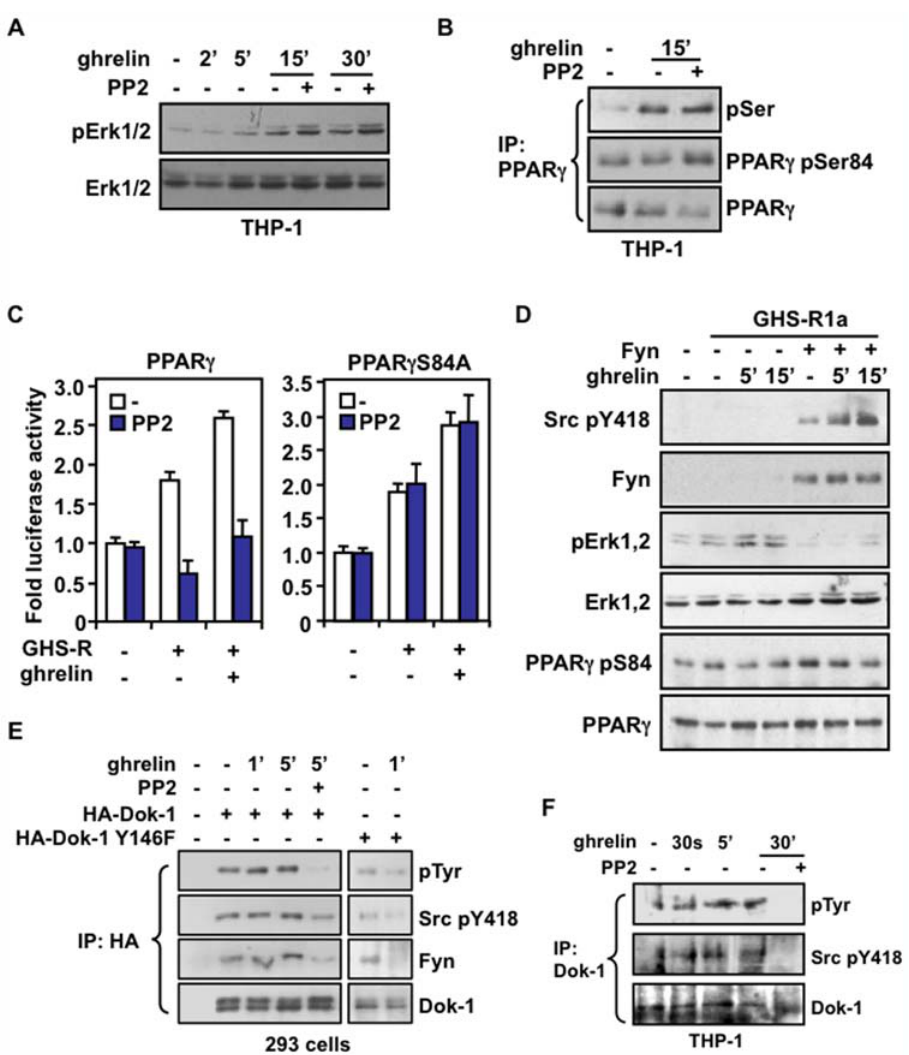
Figure 5. The ghrelin-induced PPAR c activation involves a negative regulation of Erk through Fyn/Dok-1 interaction. ( A ) Src inhibition increases Erk1/2 activity in differentiated THP-1 cells serum-deprived for 16 h and incubated with 1 m M PP2 for 30 min before incubation with 10 nM ghrelin for 2 to 30 min. The lysates were analyzed by immunoblot with antibodies specific to phospho-Erk1/2 and total Erk1/2. ( B ) Phosphorylation of PPAR c Ser-84 is increased by Src inhibition in THP-1 cells. Cells were treated as in (A), and lysates were immunoprecipitated with an antibody against PPAR c and analyzed by immunoblot using antibodies against phospho-serine, PPAR c pSer-84, and total PPAR c . ( C ) The PPAR c S84A mutant is insensitive to Src inhibition. 293 cells were transfected with UAStkLuc reporter in absence or presence of GHS-R1a, and with Gal4- PPAR c ( left ) or Gal4-PPAR c S84A ( right ) plasmids. Cells were then treated with 10 nM ghrelin with or without 1 m M PP2 for 20 h, and harvested for luciferase assay. Normalized values are presented as fold changes 6 SEM compared with untreated cells in presence of GHS-R1a. ( D ) Expression of Fyn inhibits Erk1/2 activity and PPAR c Ser-84 phosphorylation in the presence of ghrelin. 293 cells were transfected with GHS-R1a, Fyn and PPAR c expression plasmids, and then treated with 10 nM ghrelin for 5 and 15 min. Cell lysates were immunoblotted with the indicated antibodies. ( E ) Ghrelin promotes activation of Dok-1 and its recruitment to Fyn. 293 cells were transfected with Fyn and GHS-R1a expression plasmids in presence of Dok-1 or its inactive Y146F mutant, and treated with 10 nM ghrelin for the indicated time with or without 1 m M PP2. Immunoprecipitation was carried out with an antibody against HA and analyzed by immunoblot using anti-Src pTyr-418, anti-Fyn, anti-phospho-tyrosine (pTyr) and anti-Dok-1 antibodies. ( F ) Ghrelin promotes the recruitment of Dok-1 to Fyn in THP-1 macrophages. Cells were treated as in (A) and the lysates were immunoprecipitated with an antibody against Dok-1 and analyzed by immunoblot using the indicated antibodies.